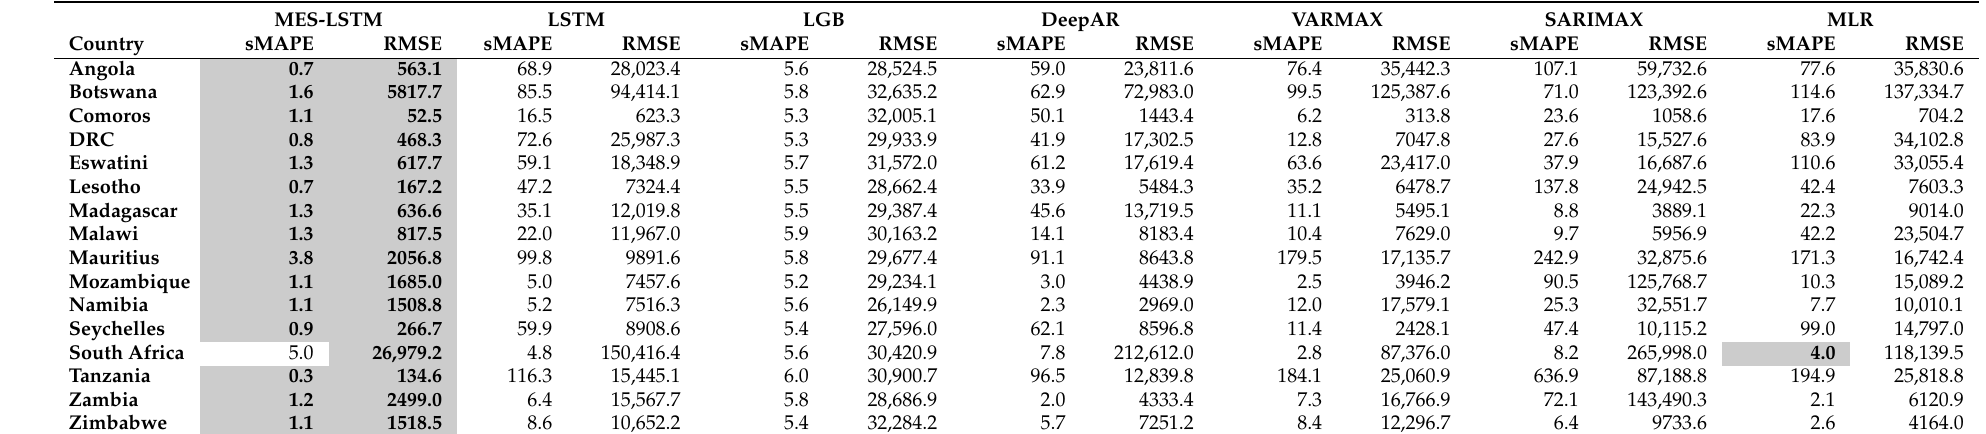
Table 4. Forecast Accuracy Averaged Over All Trials for total cases in the SADC Region.